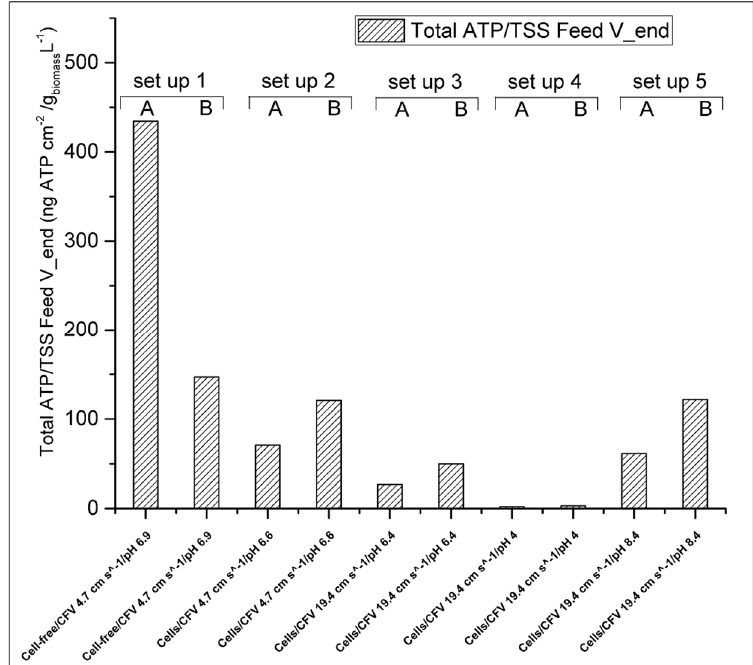
Figure 5. Total-ATP cm − 2 normalized by the final TSS in the feed. The highest normalized Total-ATP concentration was found for set-up 1 followed by set-ups 2, 5, and 3. The lowest concentration of Total-ATP was found for set-up 4. Table 2. Initial and final pH of the corresponding feed solutions. A and B correspond to the repetitions of the experimental set-ups.